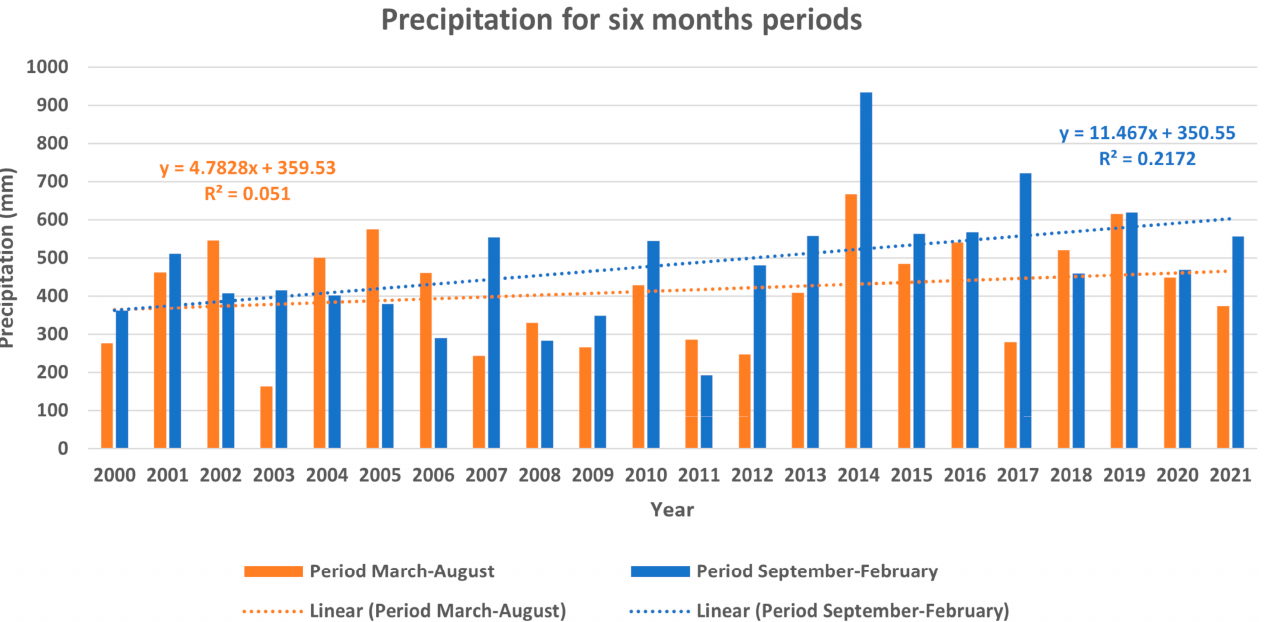
Figure 8. Precipitation for six-month periods from Kravarsko Meteorological Station for the period of 2000–2021.